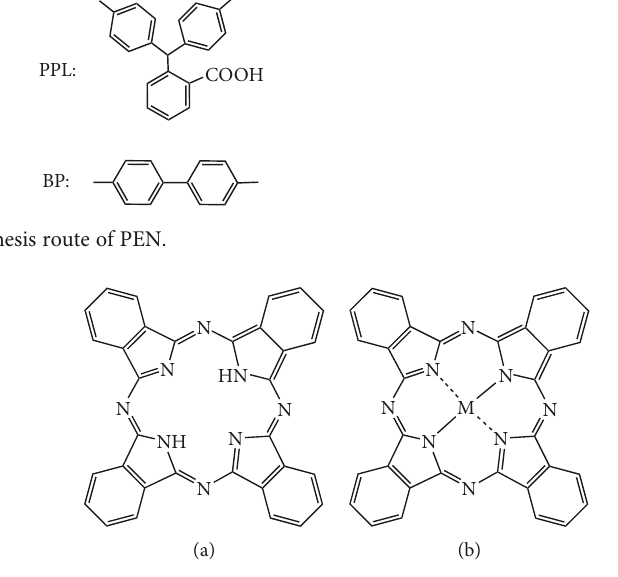
Figure 2: Structures of phthalocyanines (a) and metal phthalocyanines